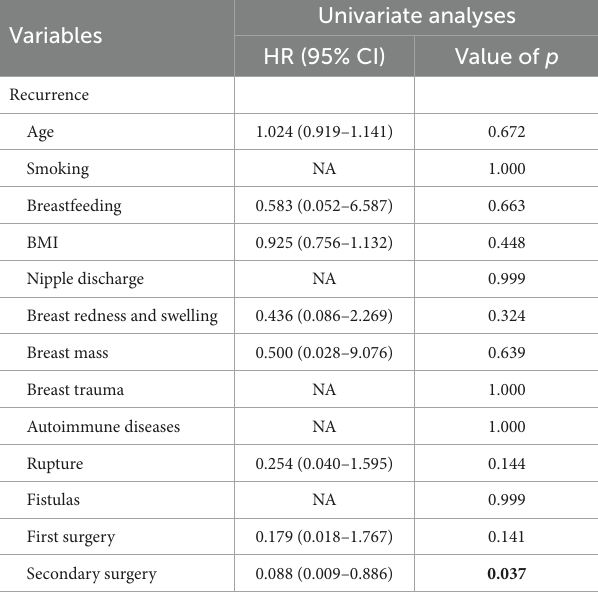
TABLE 5 Factors of postoperative recurrence in PCM patients after receiving secondary surgical treatment.